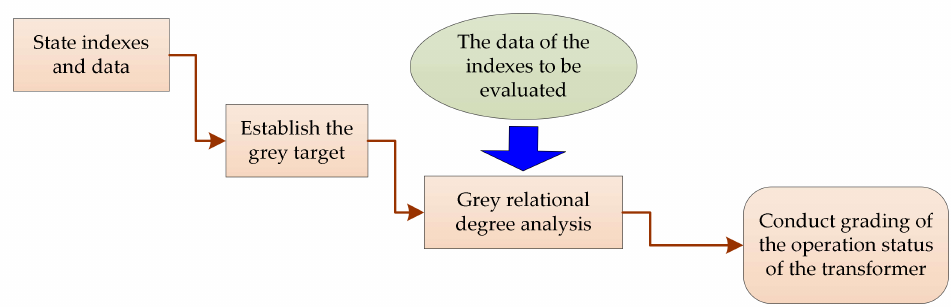
Figure 5. The evaluation flow of weighted grey theory.